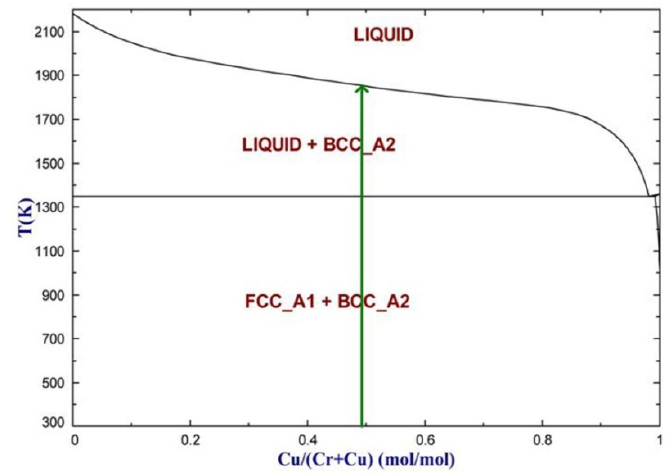
Figure 3. Cr-Cu phase diagram from FactSage 7.3 databases [32].